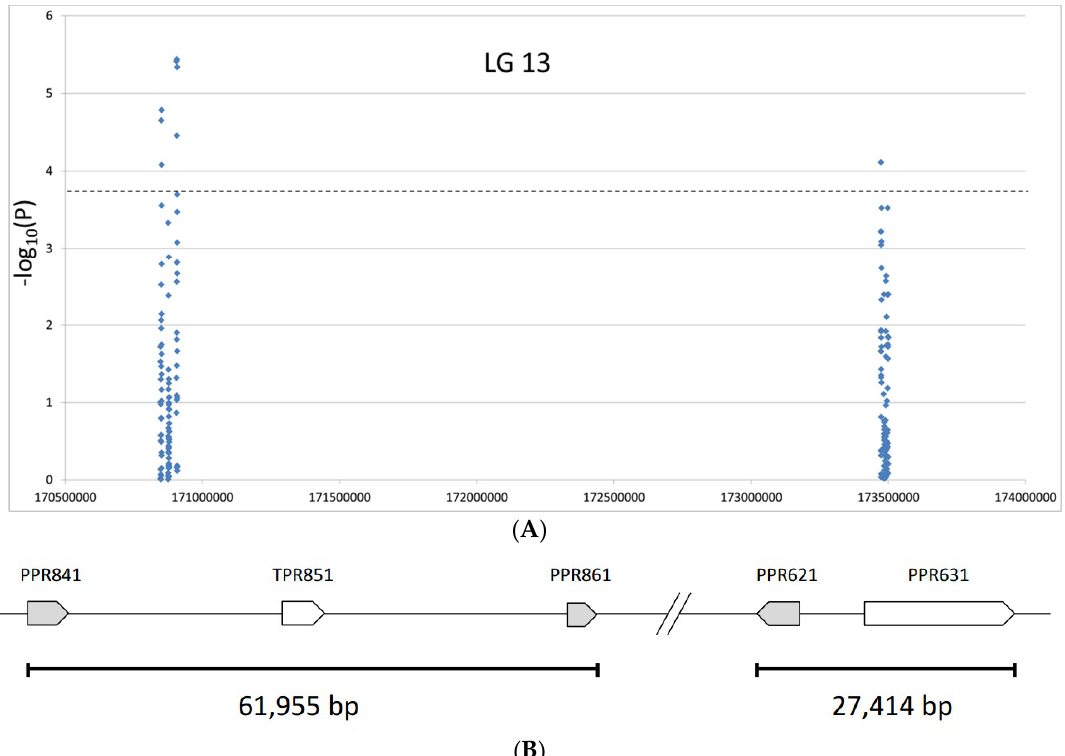
Figure 4. Distribution of SNPs present in five candidate genes for Rf1 in the 3.9-Mb-region